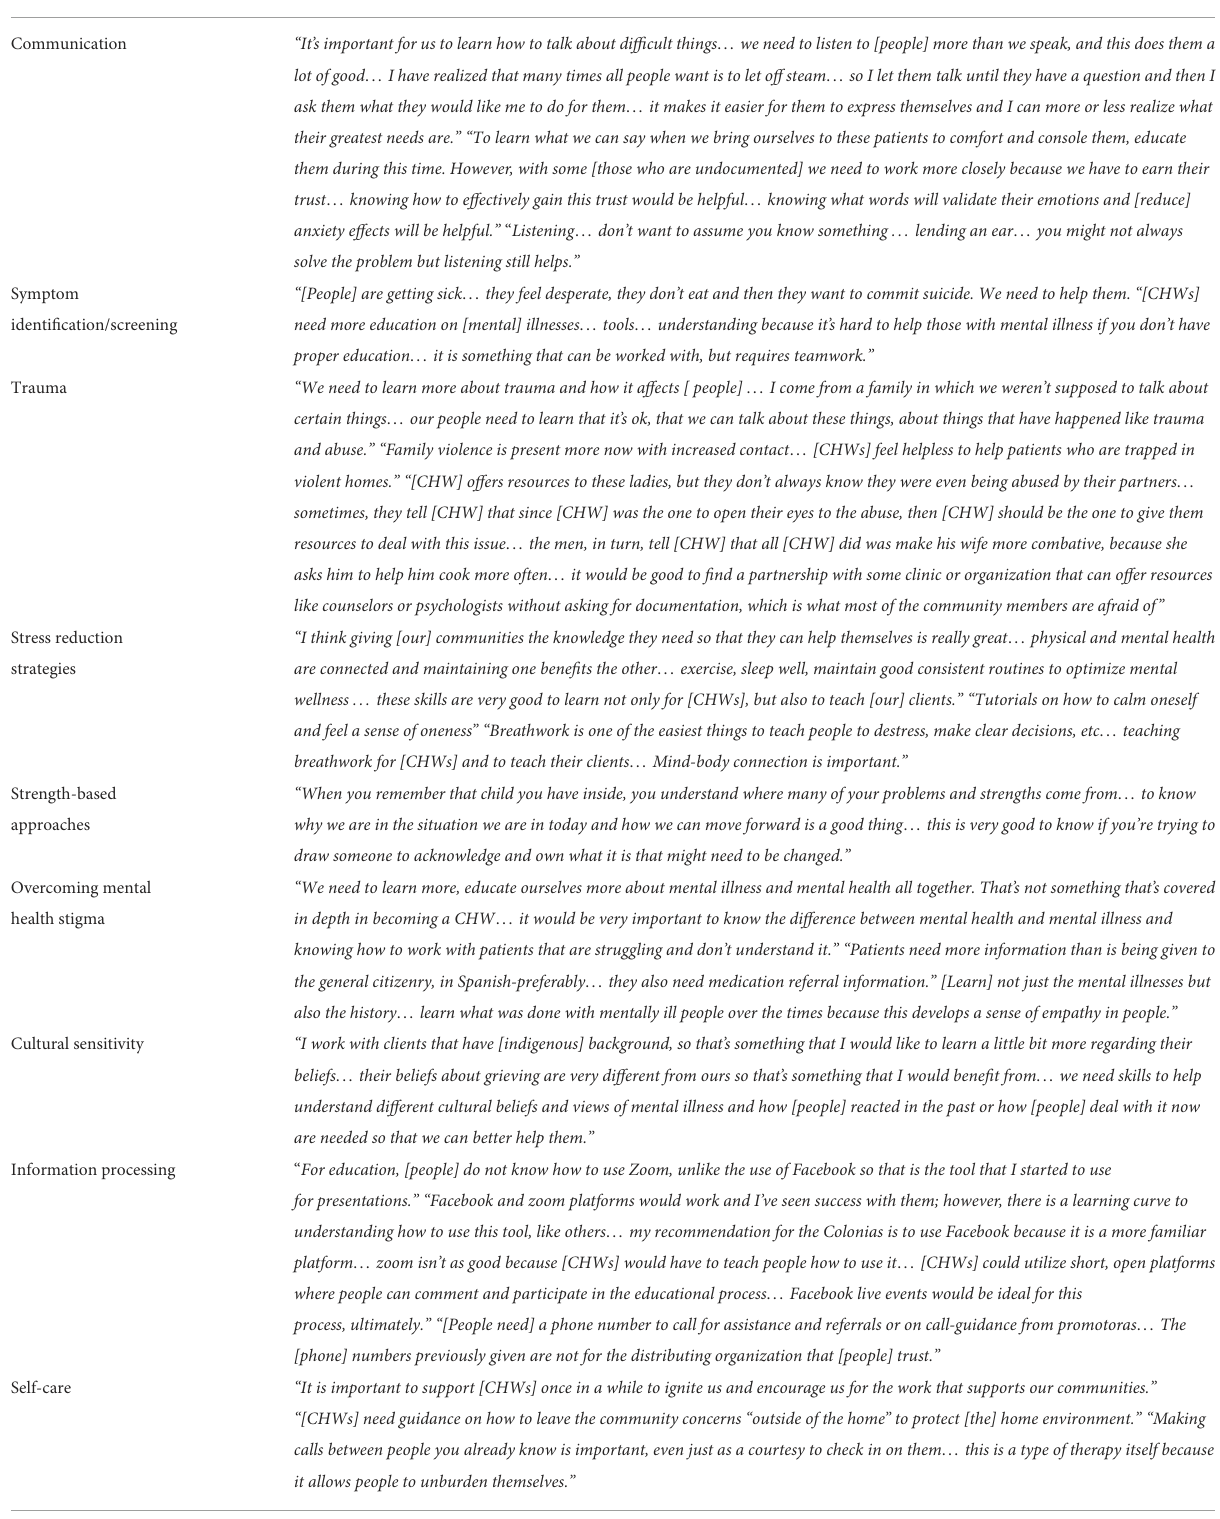
TABLE 3 Themes highlighting CHWs’ mental health training needs and sample quotations. Training need